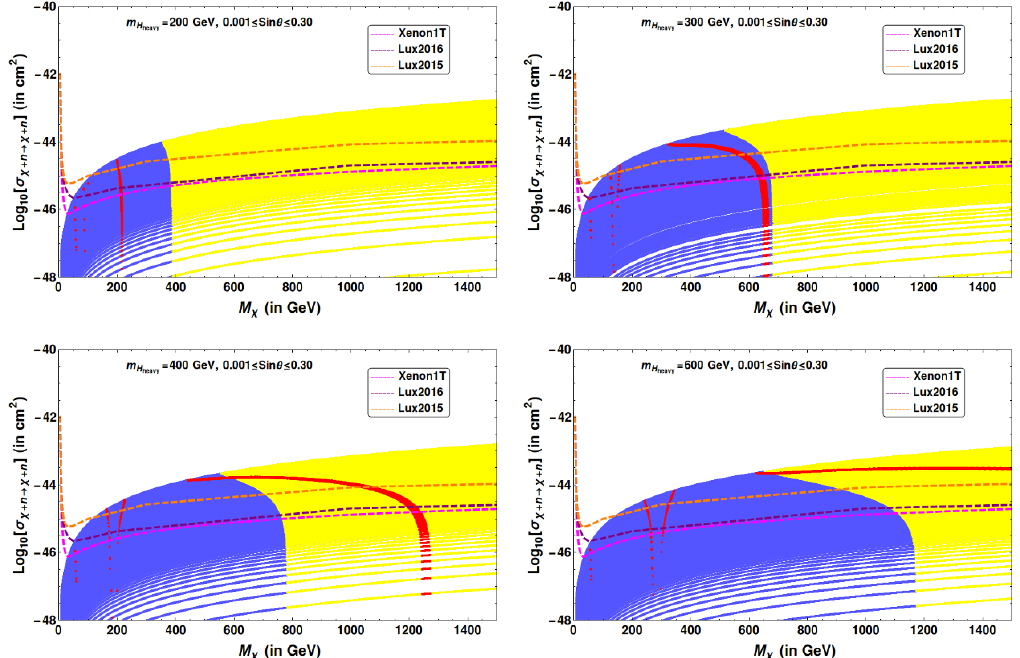
Figure 9 . Spin independent direct search cross section as a function of DM mass ( M (cid:31) ) for m H =200, 300, 400 and 600 GeV. The mixing angle is varied between 0 : 001 (cid:20) sin (cid:18) (cid:20) 0 : 3. Red Heavy dots in respective panels additionally satisfy relic density constraints. Bounds from XENON1T and LUX data are shown. The yellow region corresponds to y > 1 : 0 which may violate the perturba- tive limit. y ≥ 1 Figure 10 . Left: coupling ( y ) vs DM mass M (cid:31) in the low mass region for m H 100 GeV with 0 : 90 (cid:20) sin (cid:18) (cid:20) 0 : 999. Right: y vs M (cid:31) for high mass region with m H 600 GeV for 0 : 001 (cid:20) sin (cid:18) (cid:20) 0 : 3. The yellow region corresponds to y > 1 : 0 which may violate the perturbative